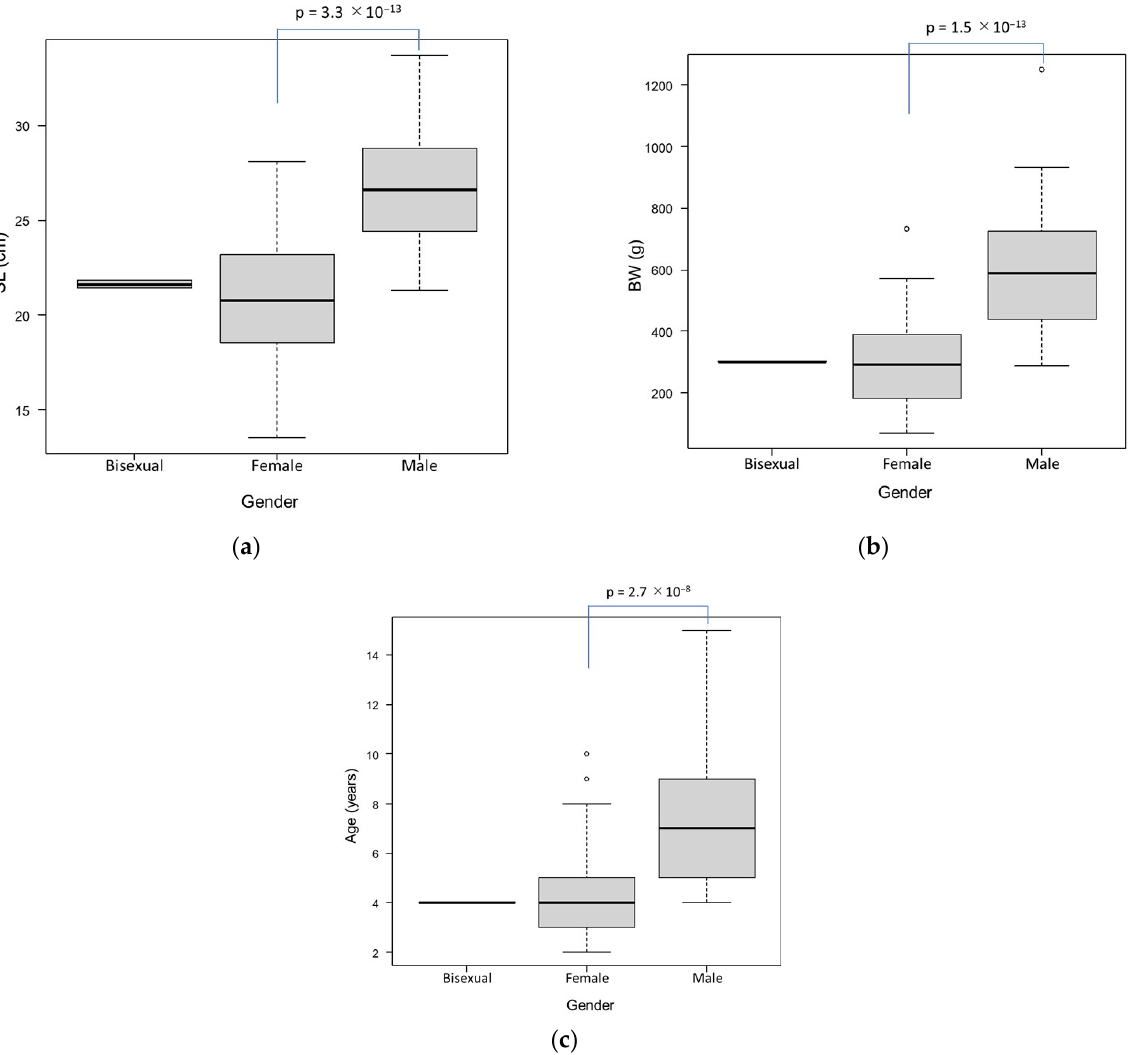
Figure 7. Distributions of ( a ) the standard length (SL), ( b ) body weight (BW), ( c ) and age relationship to the gender of the specimens of V. albimarginata captured from Okinawa. B: bisexual, F: female, M: male.